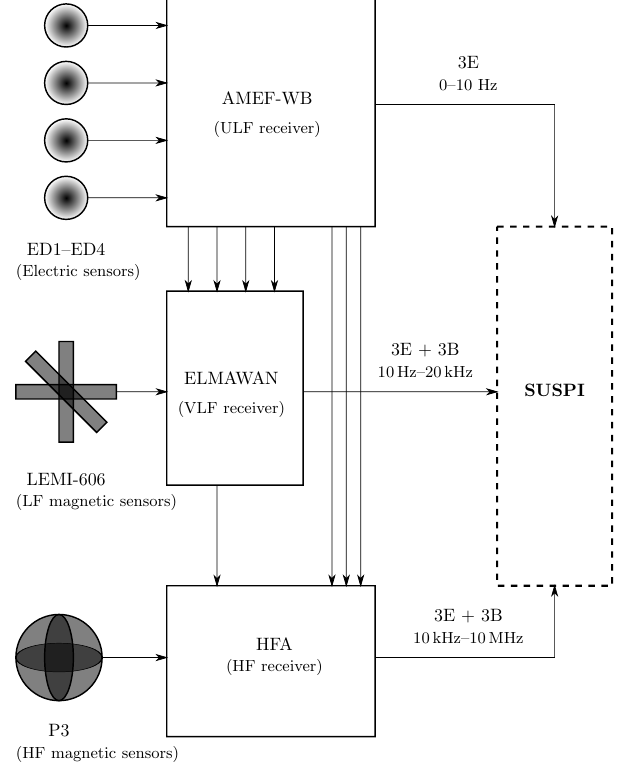
Figure 1. Block diagram of the RESONANCE particle and plasma wave